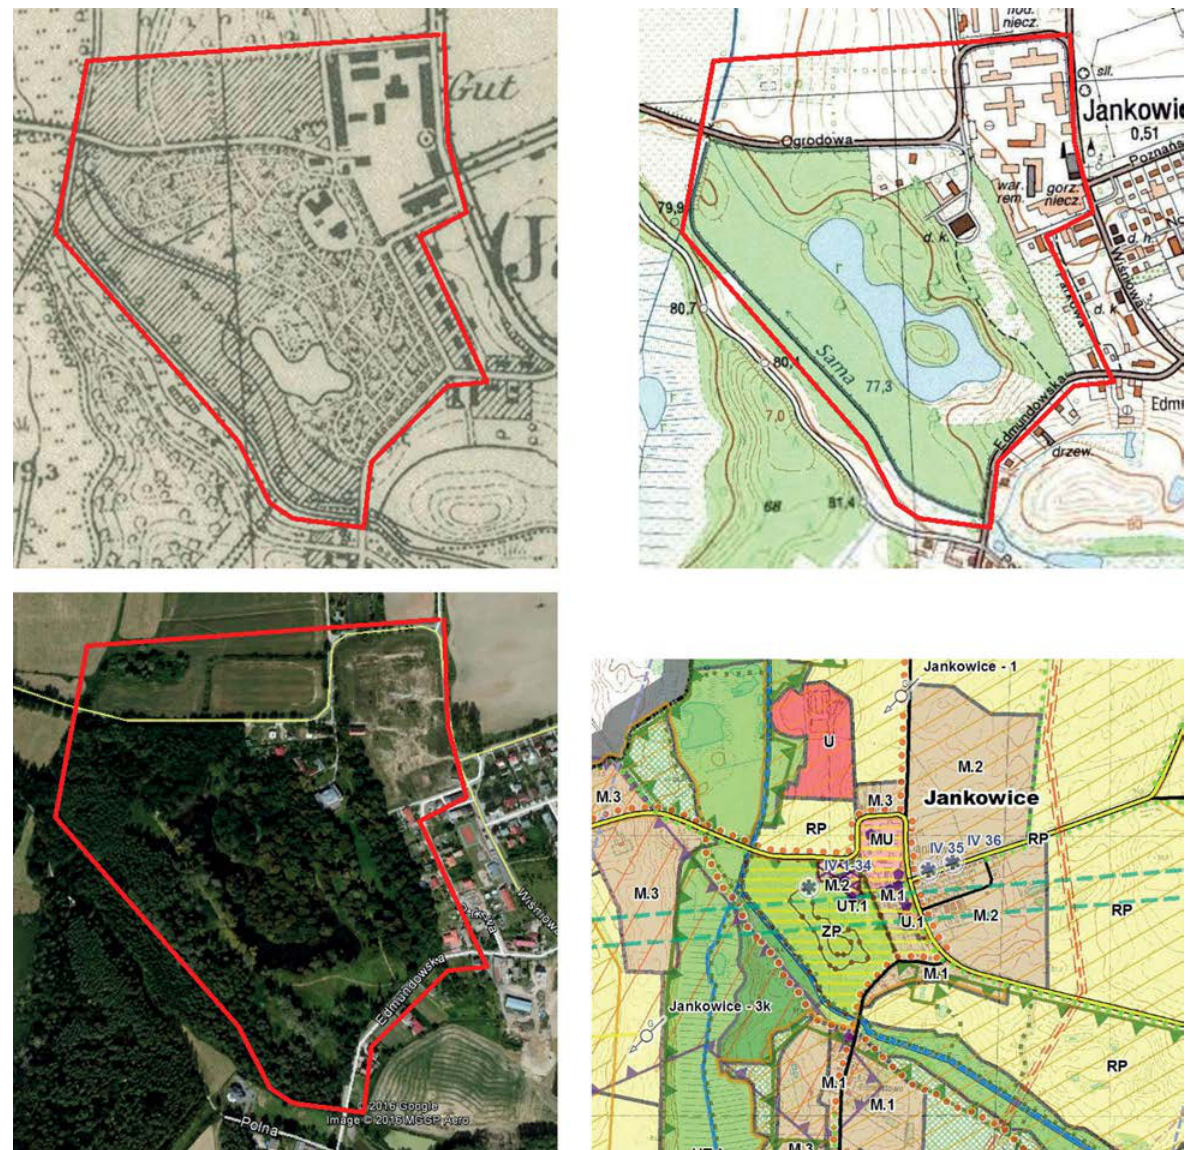
Fig. 6. Spatial arrangement of the Jankowice manorial and grange complex on maps issued in the 1940s and 1970s and the present state of the complex on an orthophoto map (the range of the complex is marked with a red line), the conservation zone delineated for the complex in the Land Use Plan (yellow horizontal lines). Source: own compilation based on http://mapy.amzp.pl; http://mapy.geoportal.gov.pl; http://mapa.inspire-hub.